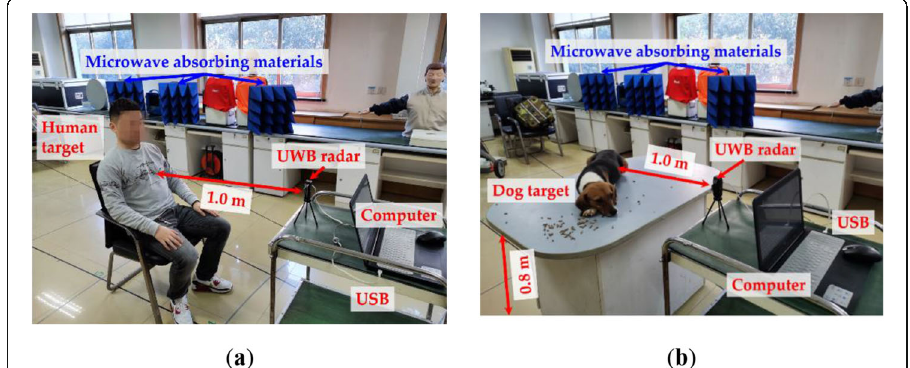
Fig. 7 Experimental scenarios. a Human target. b Dog